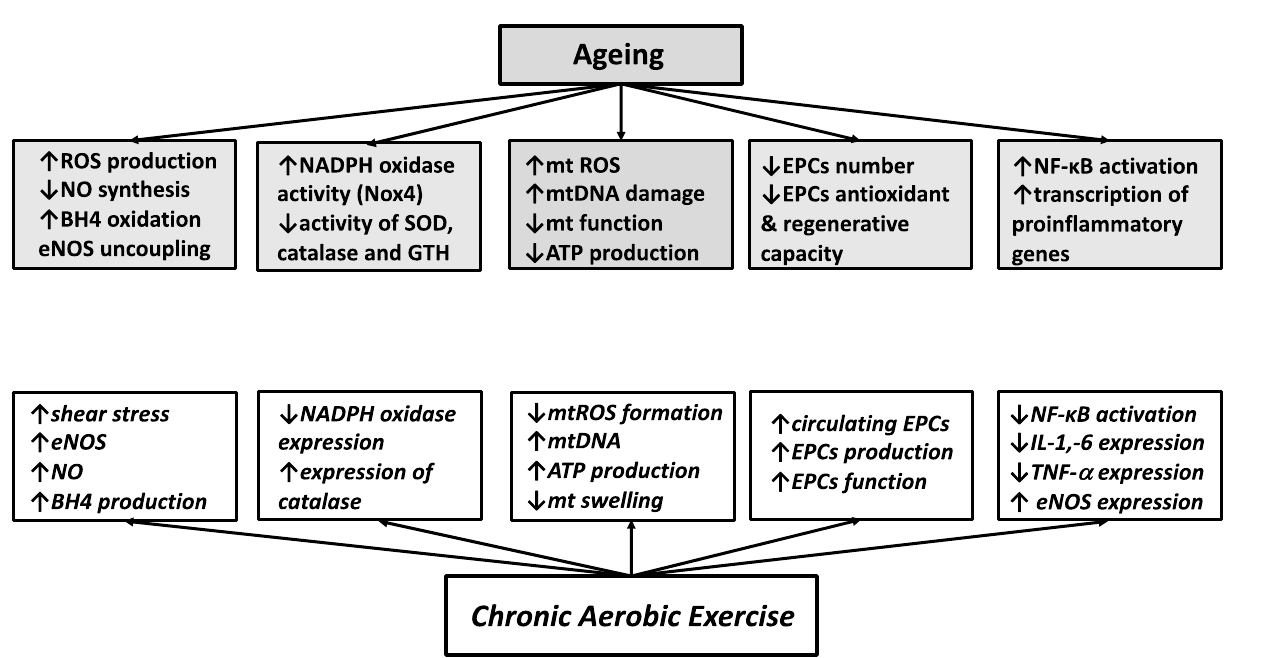
Figure 1. Mechanisms through which ageing deteriorates endothelial function (grey rectangles) and mechanisms through which chronic aerobic exercise improves endothelial dysfunction (white rectangles). ROS: reactive oxygen species; NO: nitric oxide; BH4—tetrahydrobiopterin; eNOS: endothelial nitric oxide synthase; NADPH: nicotinamide-adenine-dinucleotide phosphate; SOD: superoxide dismutase; GTH: glutathione; mt: mitochondrial; EPCs: endothelial progenitor cells; NF- κ B: nuclear factor kappa-light-chain-enhancer of activated B cells; IL: interleukin; TNF- α : tumor necrosis factor- α .